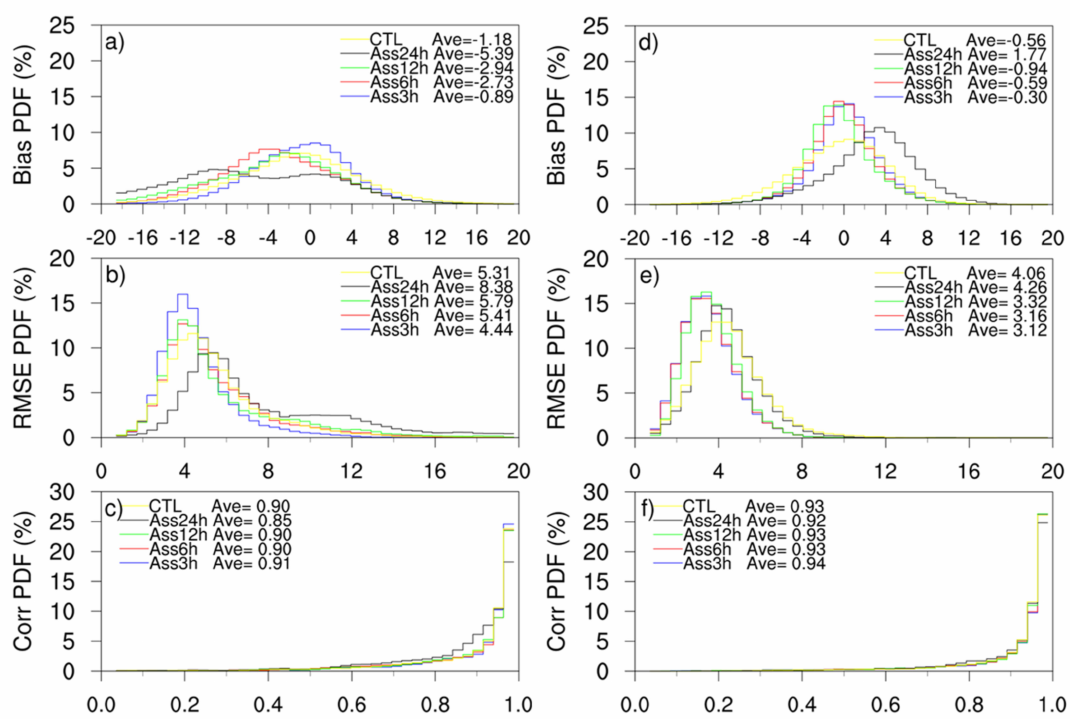
Figure 10. The PDFs of the bias ( a , d ), the RMSE ( b , e ), and the time correlation coefficient ( c , f ) for the CTL experiments and the assimilation experiments at daytime (left column) and nighttime (right column)